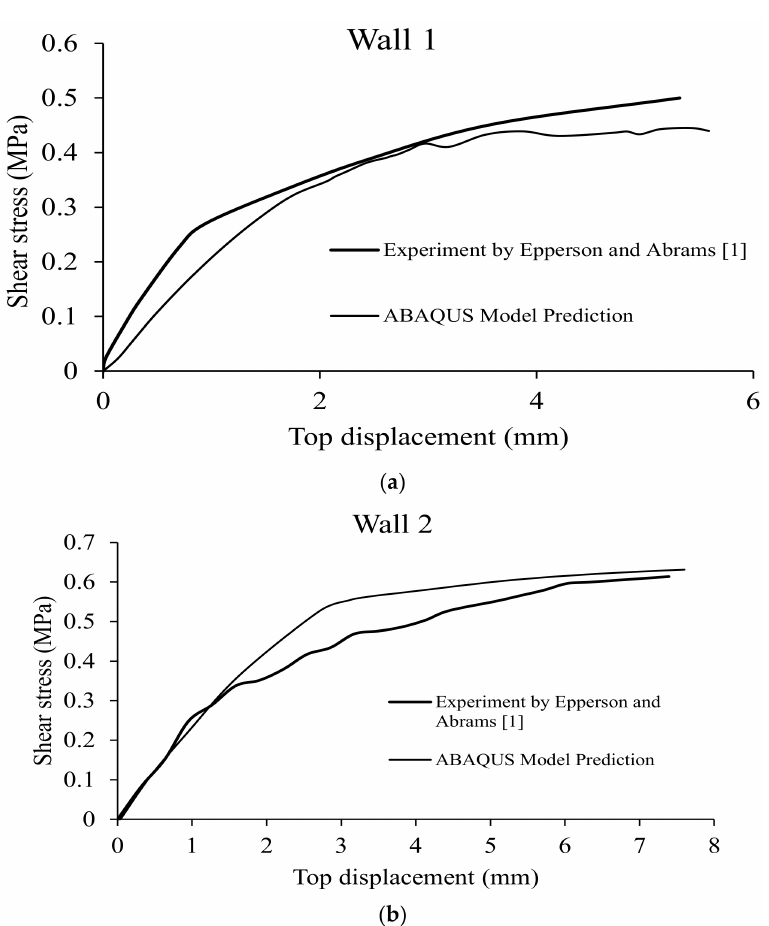
Figure 7. Experimental and numerical shear stress versus top displacement curves: ( a ) model “Wall 1”, ( b ) model “Wall